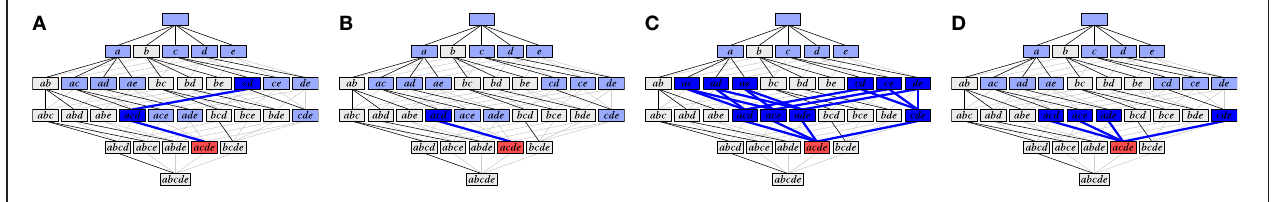
FIGURE 6 | Illustration of different types of subset conditions (cf. Figure 4A). (A) Weak subset conditions down to pairs; (B) Weak subset conditions down to triplets; (C) Strong subset conditions down to pairs; (D) Strong subset conditions down to triplets.